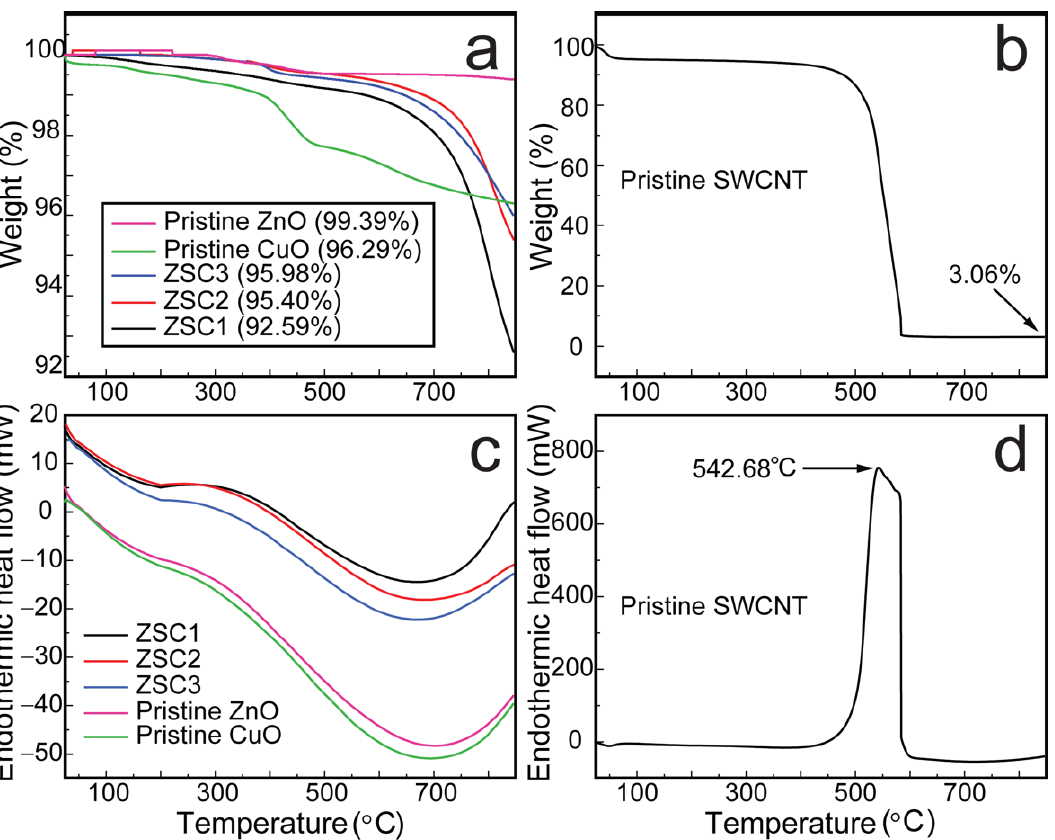
Figure 5. The thermal analysis of ZSC heteronanocomposites and pristine samples. The thermogravimetry plots of ( a ) the heteronanocomposites, pristine ZnO, and pristine CuO and ( b ) pristine SWCNTs. The differential scanning calorimetry thermograms of ( c ) the heteronanocomposites, pristine ZnO, and pristine CuO, and ( d ) pristine SWCNTs.